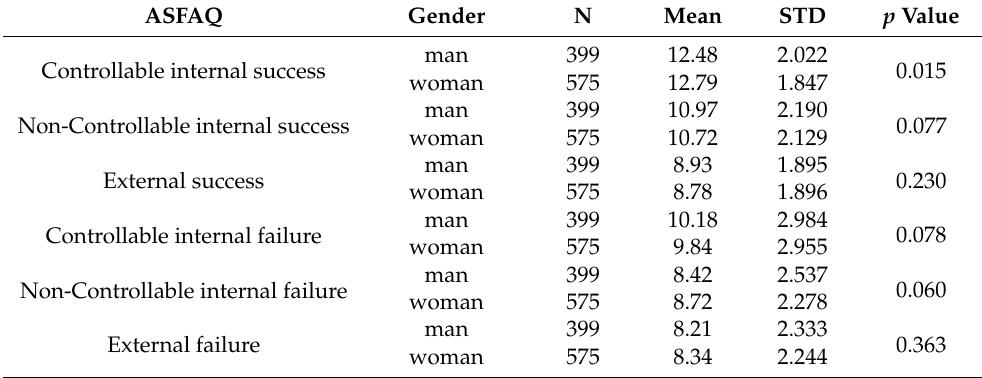
Table 2. Results of the T-test for independent samples between ASFAQ and gender. ASFAQ Gender N Mean